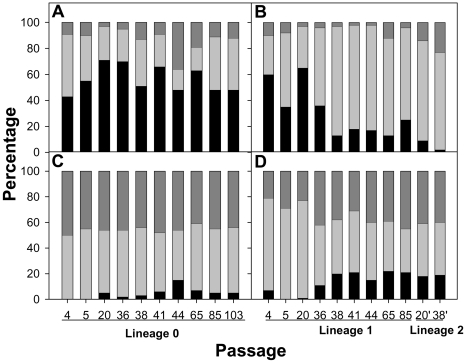
Relative proportion (percentage) of the new generated codons detected during the process of HAV adaptation to AMD.These codons were sorted as being similarly frequent (black fill), less frequent (gray fill) or more frequent (blue fill) than the original ones with respect to the cell host codon usage. A. Codon usage variation in the capsid region in the absence of AMD (lineage 0). B. Codon usage variation in the capsid region in the presence of 0.05 µg/ml of AMD (lineage 1) from passage 4 to passage 85, and in the presence of 0.2 µg/ml of AMD (lineage 2) from passage 20 (P20') to passage 38 (P38'). C. Codon usage variation in the polymerase region in the absence of AMD (lineage 0). D. Codon usage variation in the polymerase region in the presence of 0.05 µg/ml of AMD (lineage 1) from passage 4 to passage 85, and in the presence of 0.2 µg/ml of AMD (lineage 2) from passage 20 (P20') to passage 38 (P38').